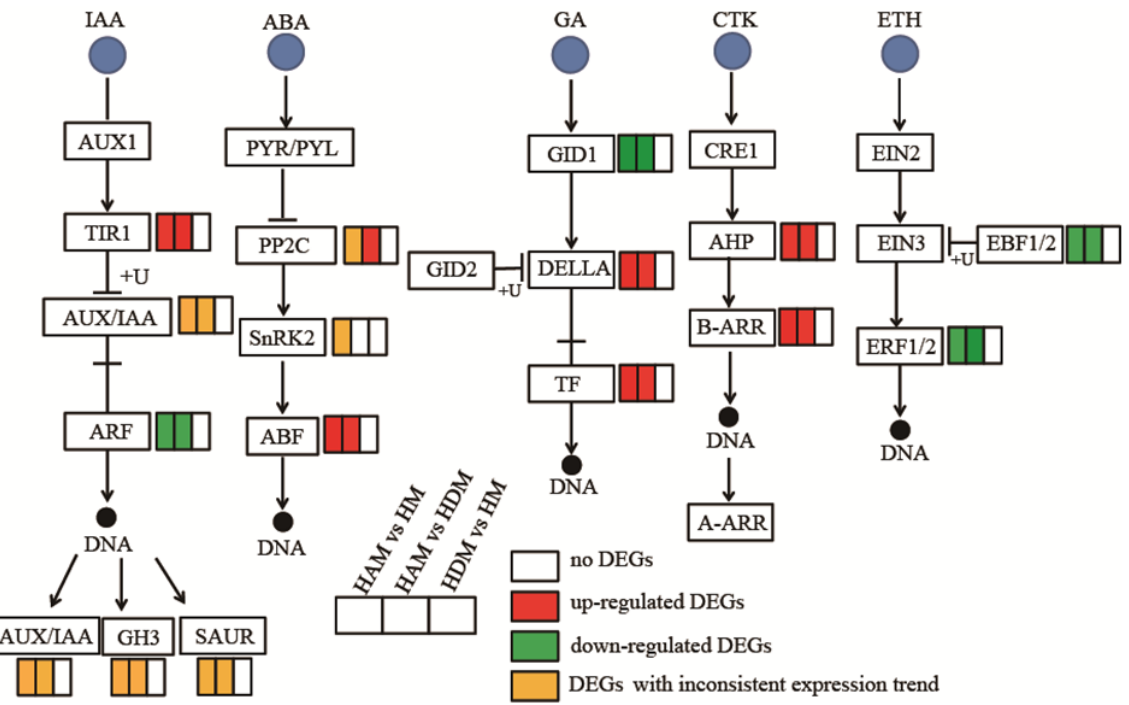
Figure 7. Interstocks induced changes in the expression profiles of hormone signaling pathway genes in three comparisons. The rectangles behind the gene, which were tagged with red, green, white and yellow color, represent the upregulated DEGs, downregulated DEGs, unchanged DEGs and the DEGs with inconsistent expression trends, respectively.